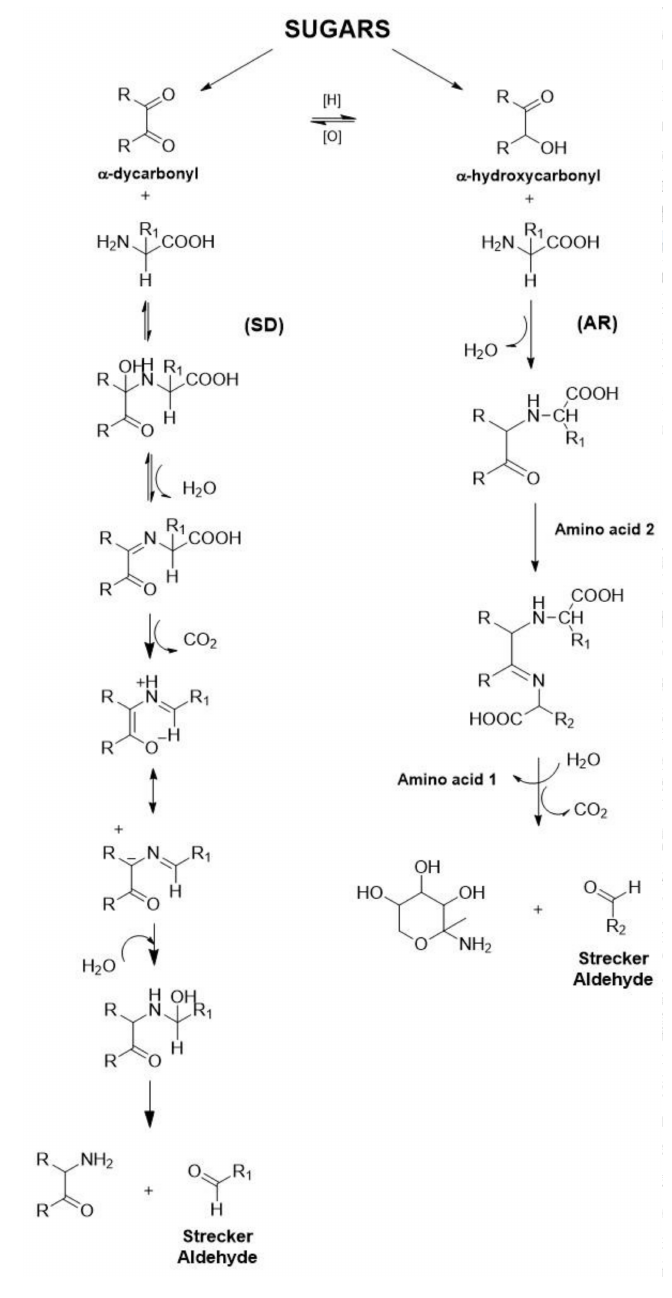
Figure 1. Strecker degradation (SD) reaction of α -dicarbonyl and Amadori rearrangement (AR) of α -hydroxycarbonyl forming Strecker